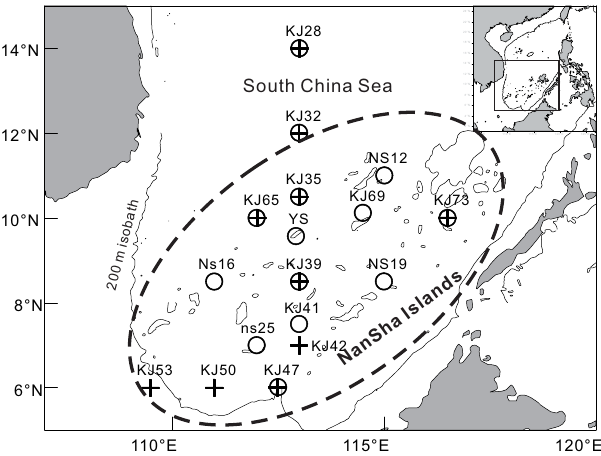
Figure 1. Stations for dilution experiments in the southern South China Sea during May to June 2009 and November 2010. The open circle indicates experimental stations during May to June 2009; the cross indicates experimental stations during November 2010. The dashed circle shows the schematic area of the Nansha